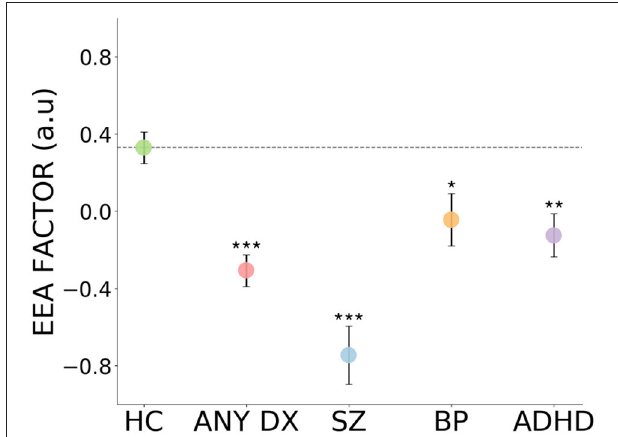
FIGURE 4 | Impaired evidence accumulation across psychiatric diagnoses. The evidence accumulation factor is significantly reduced in all patients, collapsing across the three diagnoses, in comparison to healthy controls. It is also reduced in each patient groups separately in comparison to healthy controls. HC, Healthy Controls; ALL DX, All three patient groups combined; SZ, Schizophrenia; BP, Bipolar Disorder; ADHD, Attention-deficit/hyperactivity Disorder; a.u., arbitrary units. Error bars reflect represent standard error. *** p < 0.001, ** p < 0.01, * p < 0.05.